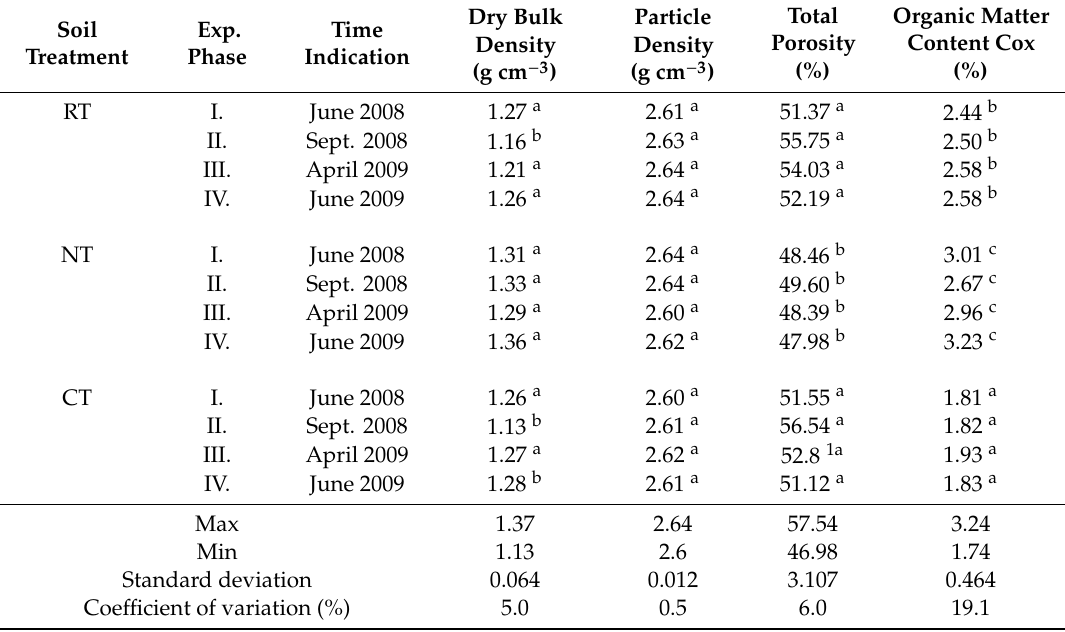
Table 2. Summary of the basic soil characteristics determined for the top 10 cm of the tested soil, superscript letters a, b, c indicate membership in a homogeneous group based on Fisher’s least significant di ff erence (LSD) procedure with 95% confidence